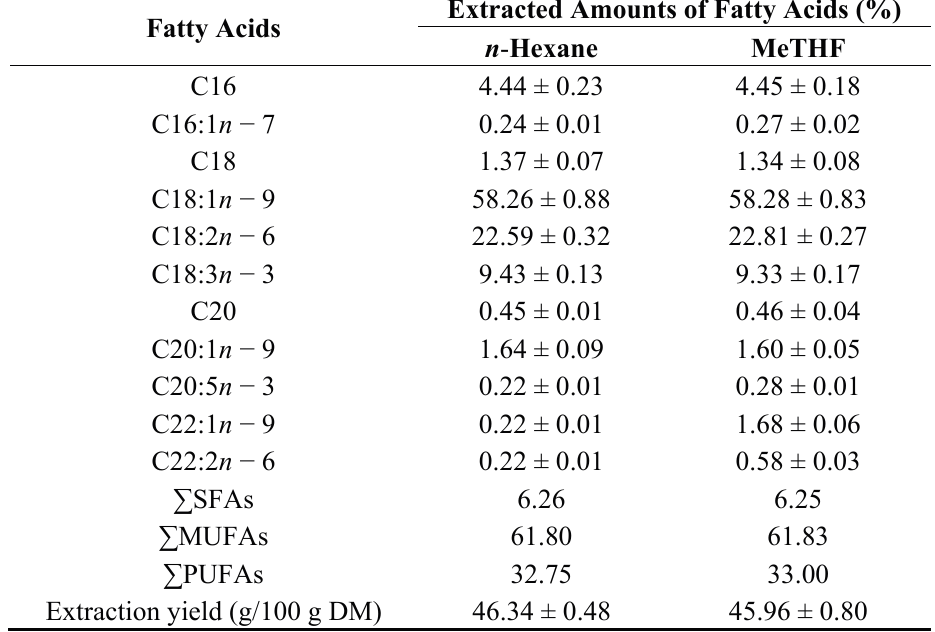
Extracted Amounts of Fatty Acids